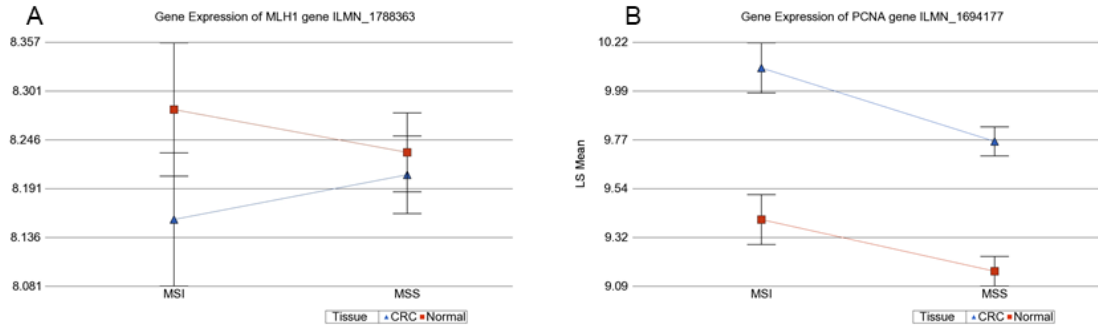
Figure 8. Differential gene expression of MLH1 and PNCA in the tumor (in blue) compared to normal tissue (in red). ( A ) Shows no differential expression of the MLH1 gene in MSI and MSS. ( B ) Shows an overexpression of PCNA in the tumor, in both MSI and MSS.